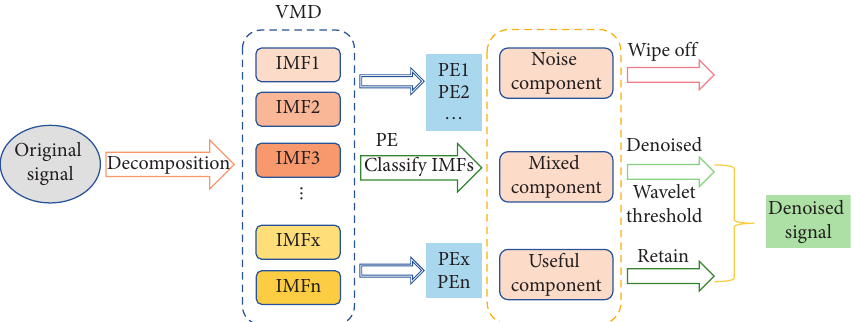
Figure 2: The steps of VMD-PE-wavelet threshold algorithm.